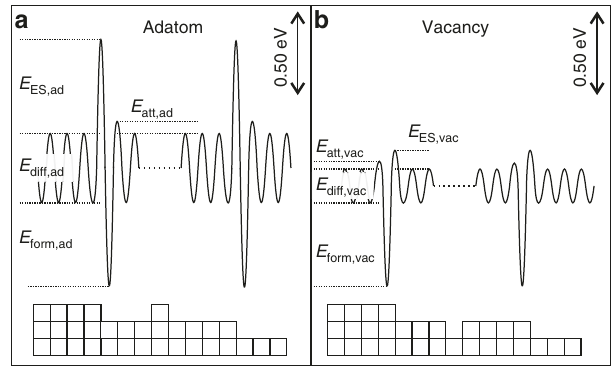
Fig. 2 Local potential energy surface for a an adatom and b a single vacancy on a stepped Cu(100) surface. The energies are drawn to scale based on known values 10 –